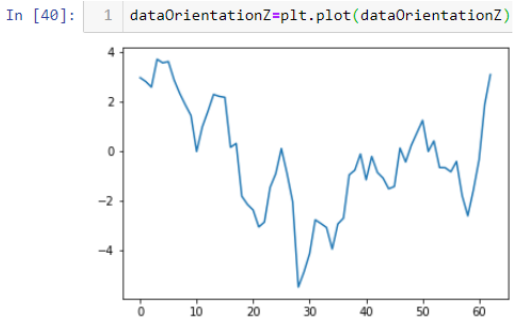
Figure 53. Orientation of the user between −12 and −20, i.e., between north and west.